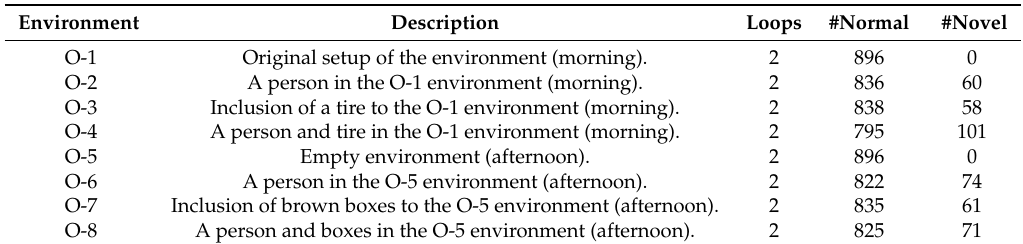
Table 2. Summary of the environments used in the experiments for novelty detection.